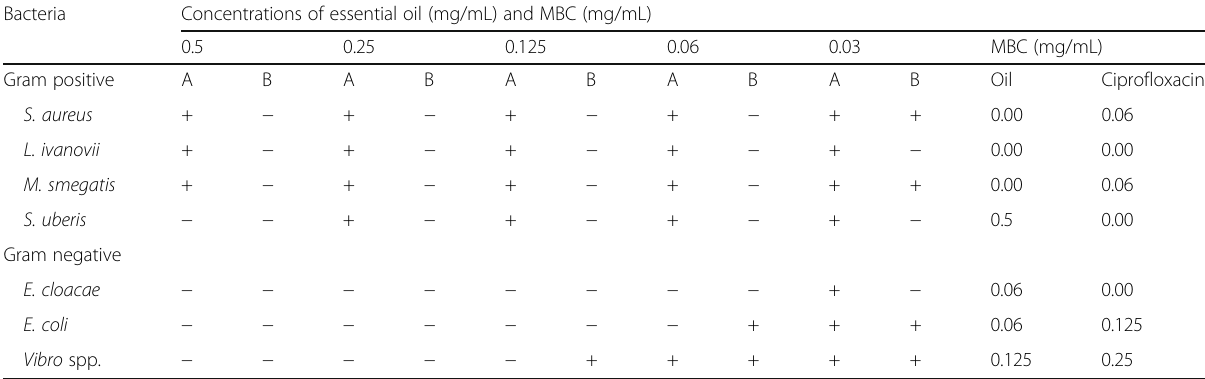
Table 4 Minimum bactericidal concentrations (MBC) of essential oil of T. minuta flower